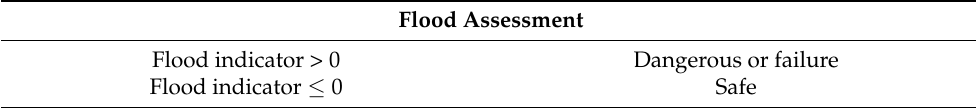
Table 17. Standard for flood assessment.